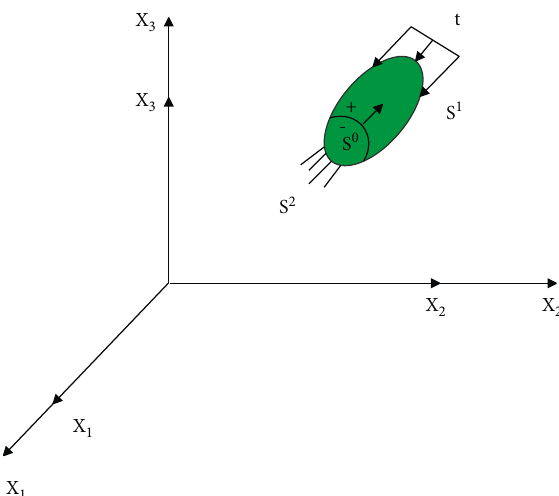
Figure 1: Sketch of the boundary conditions of the deformed